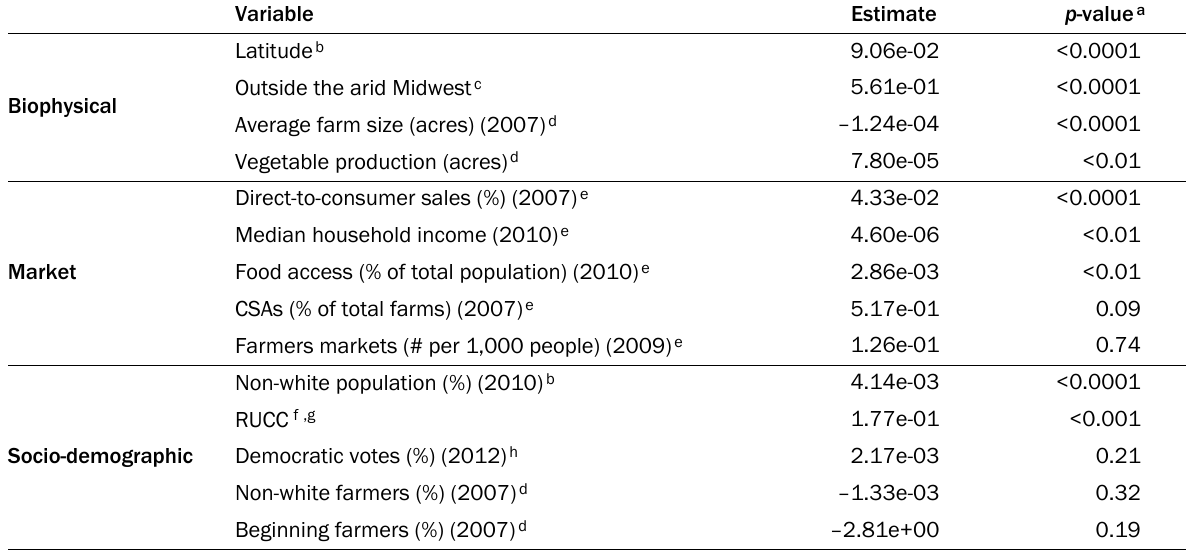
Table 1. Relationships Between USDA Natural Resources Conservation Service (NRCS) High Tunnel Adoption and Biophysical, Market, and Socio-demographic